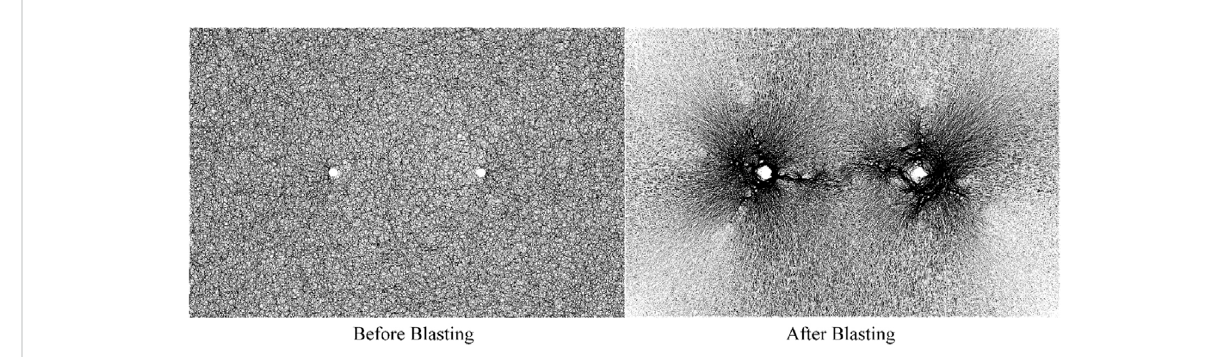
FIGURE 8 Schematic diagram of particle contact force before and after blasting.